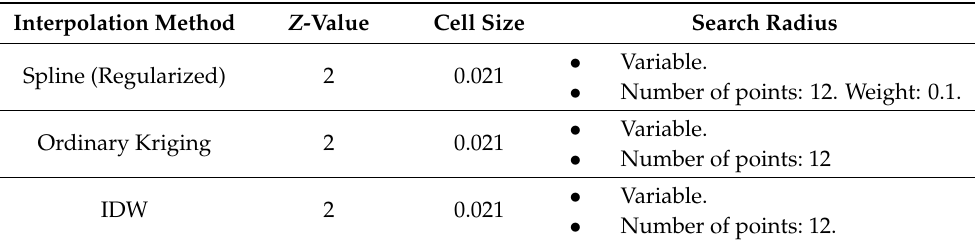
Table 3. ArcGIS Inputs for each interpolation